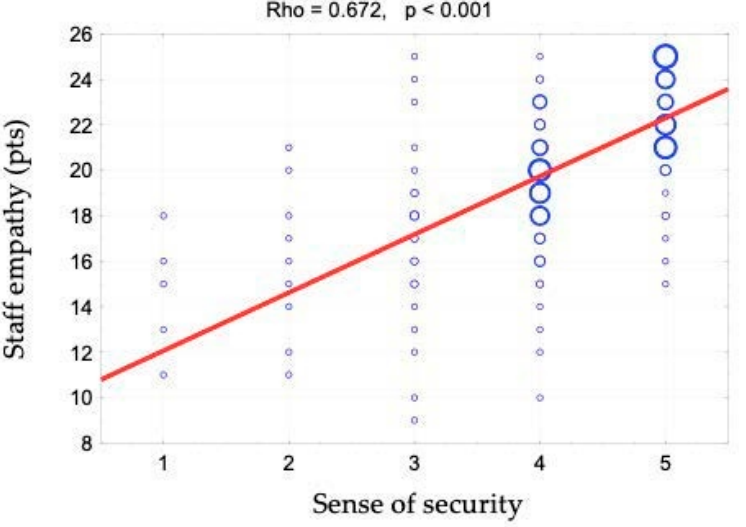
Figure 7. Correlation diagram between the sense of security (1—definitely not, 2—rather not, 3— partially, 4—rather yes, 5—definitely yes) and staff empathy and the value of Spearman’s rank correlation coefficient (rho) .